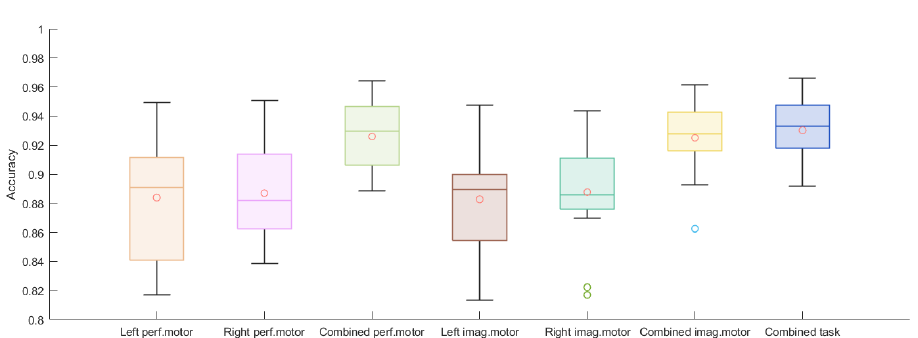
Figure 8. Boxplots of 15 subjects’ averaged accuracies for 5-fold cross-validation for left performed motor, right performed motor, combined performed motor, left imagined motor, right imagined motor, combined imagined motor, and combined tasks.